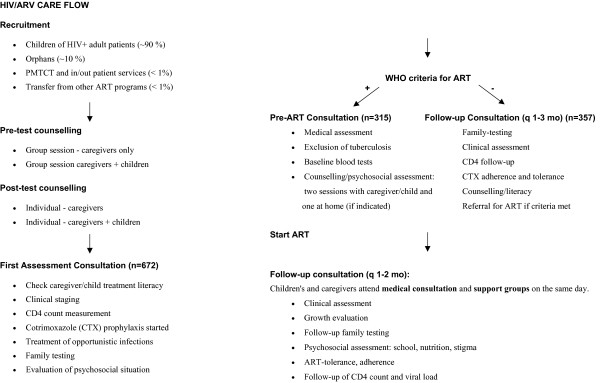
Flow diagram of the pediatric HIV program. ART: antiretroviral treatment; PMTCT: Prevention of Mother To Child Transmission; WHO: World Health Organization.